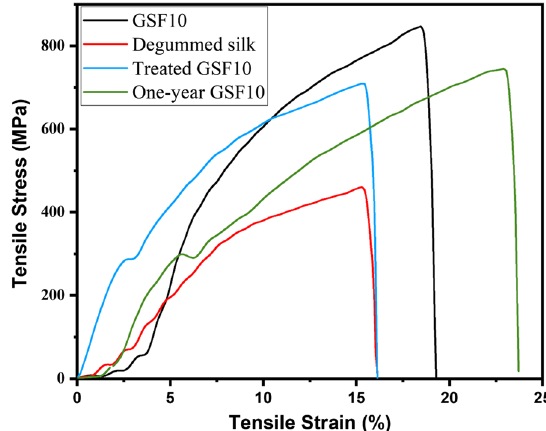
Fig. 3 Stress–strain curves of degummed fibers and various GSF10 (Treated GSF10: GSF10 that had been stored in a constant temperature and humidity chamber at 40 degrees and 30% humidity for 15 days; One-year GSF10: GSF10 that had been stored for